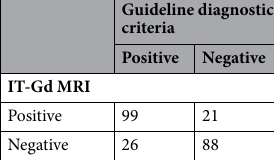
Guideline diagnostic criteria